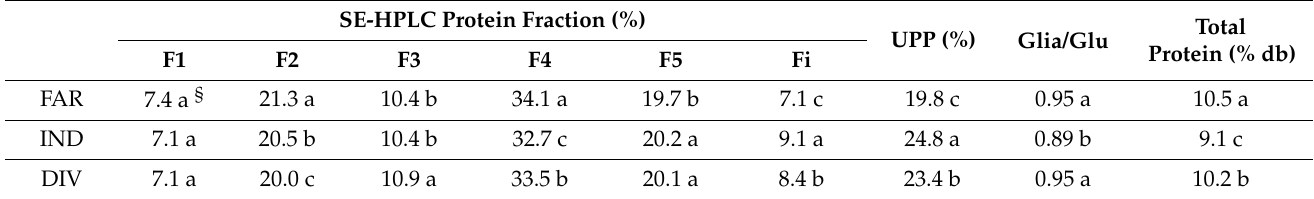
Table 7. Means of protein content and protein fractions measured on lab-milled grains (H2016, H2017 and H2019) in 3 groups of varieties. FAR: varieties used by the farmer pasta makers; IND: varieties recommended by the industry; DIV: underutilized genetic resources .